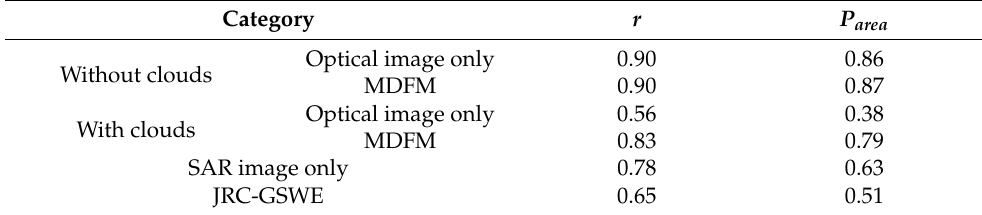
Table 3. Accuracy of water extraction results in different images. Category r P area Optical image only 0.90 Without clouds Optical image With clouds